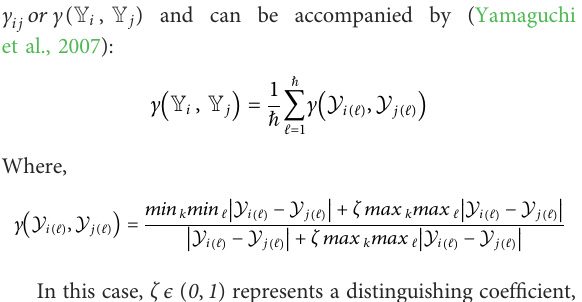
grey framework employed in our research is displayed in Figure 1.